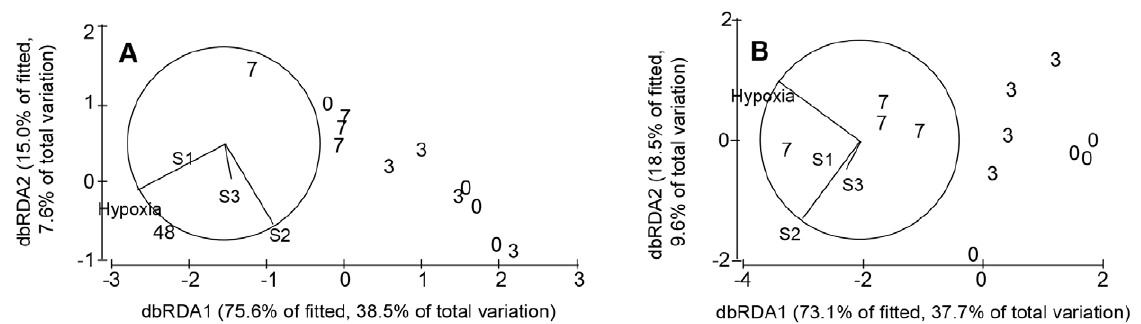
Figure 4. Ordinations illustrating changes in ecosystem functions as directed by the duration of hypoxia and the benthic community. In (A) all treatments are included, while (B) represents the 0, 3 and 7-day treatments. The vector overlays correspond to multiple partial correlations of the predictor variables with the dbRDA axes. Hypoxia depicts the duration of hypoxia (days) while S1–3 depicts the PCA scores used to represent the benthic